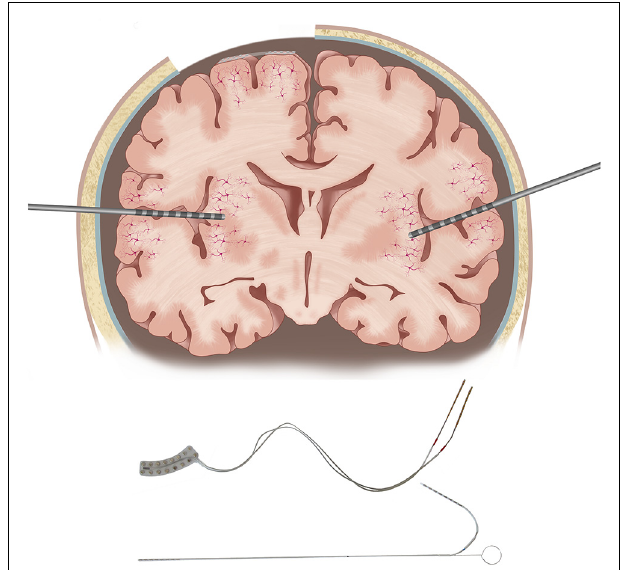
FIGURE 2 | Some important differences between subdural electrodes (SDE) and SEEG electrodes. SDE requires a craniotomy for implantation, while SEEG electrodes are implanted through burr holes. SDE cover the crowns of gyri nearly perpendicular to the dendrites of pyramidal cells, while SEEG electrodes pass at various angles concerning pyramidal cells, through both gray and white matter. Illustrations of an SDE grid and an SEEG electrode are provided in the lower panel.